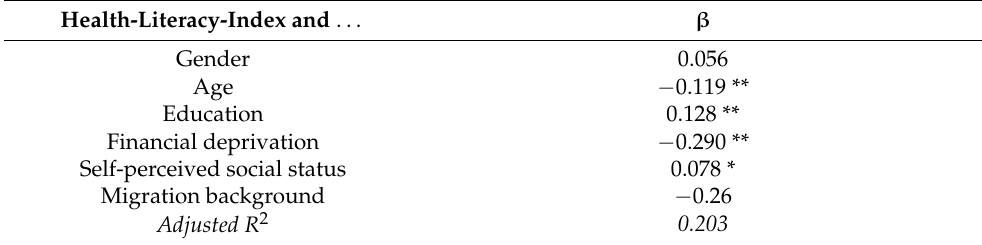
Table 4. Regression model of the Health-Literacy-Index and sociodemographic characteristics. Health-Literacy-Index and . .